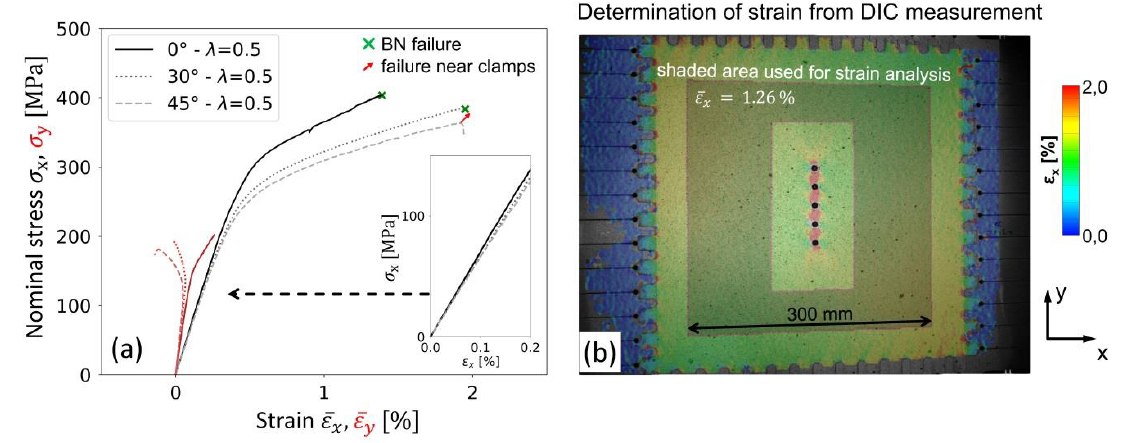
Figure 6. ( a ) Stress-strain curve for λ = 0.5, and ( b ) area considered for determination of stress and strains.